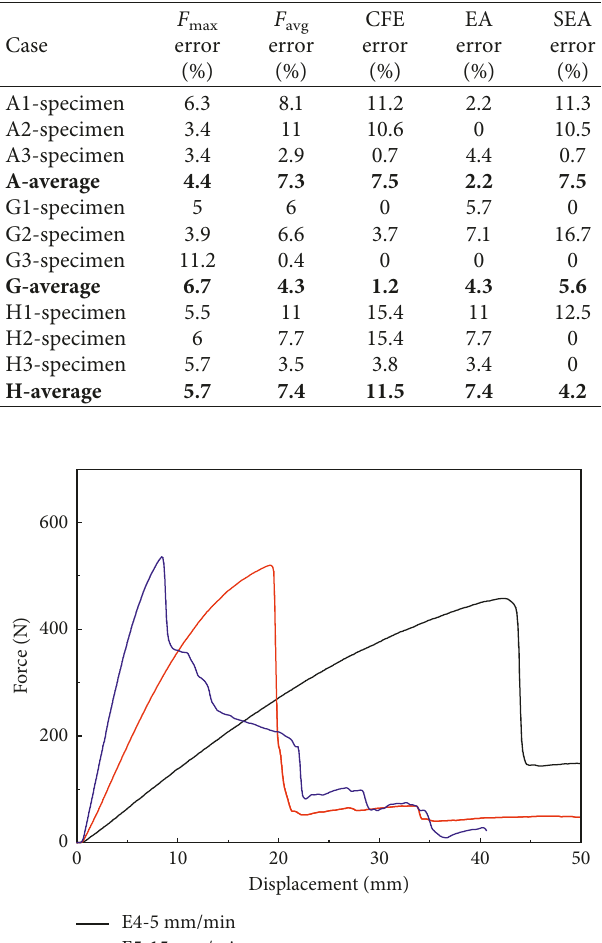
Table 7: The deviation values of the experimental results for layer thicknesses.